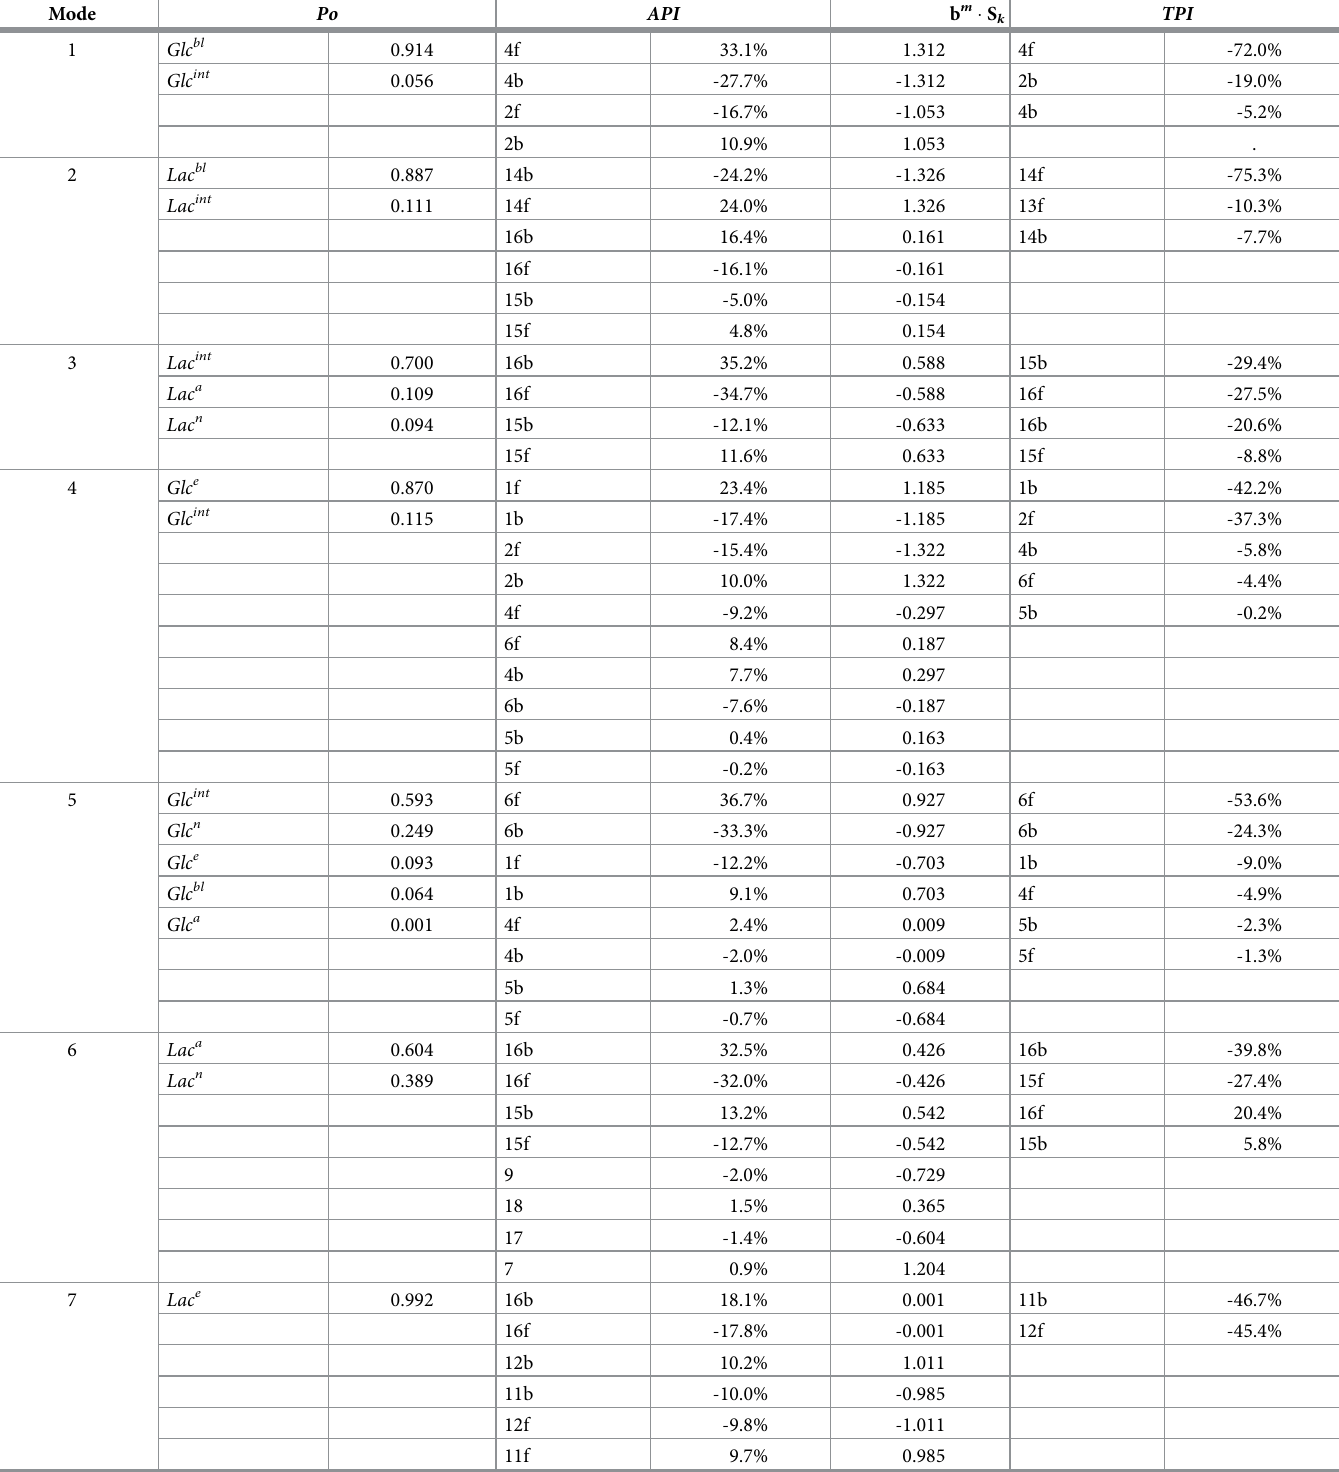
Table 2. CSP diagnostic tools for the 7 exhausted and 1 active modes in the NALS